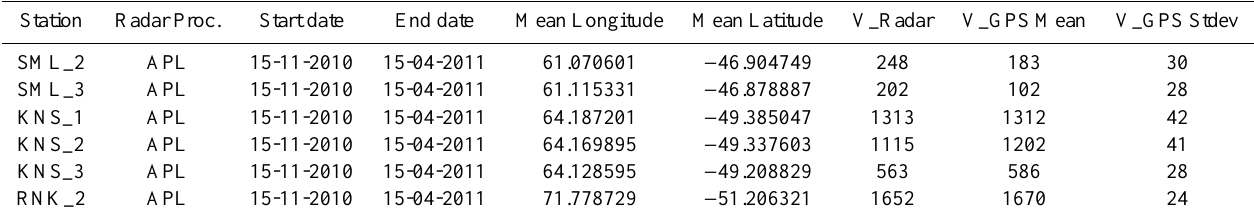
Table 3. Comparison of ice velocities derived by APL from aggregate velocity map based on TerraSAR-X satellite radar imagery and ice velocities from GPS measurements. Start and end dates refer to the time window between image acquisitions. Ice velocities are given in myr − 1 , latitudes and longitudes in decimal degrees N and W, respectively, using the World Geodetic System 1984 (WGS84). Station Radar Proc.